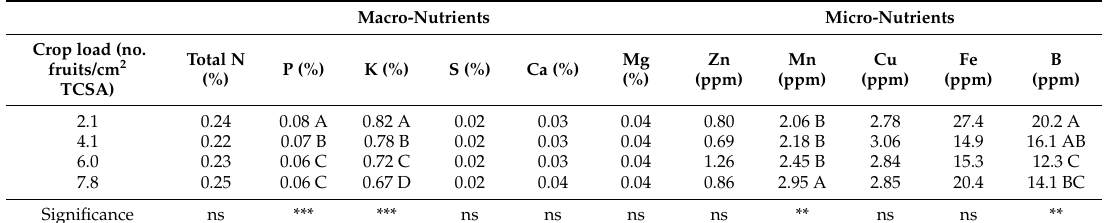
Table 6. The effects of crop load on fruit mineral composition (macro- and micro-nutrients) in fruit harvested from “WA38” trees in the fall of 2017 in Washington State, Wenatchee